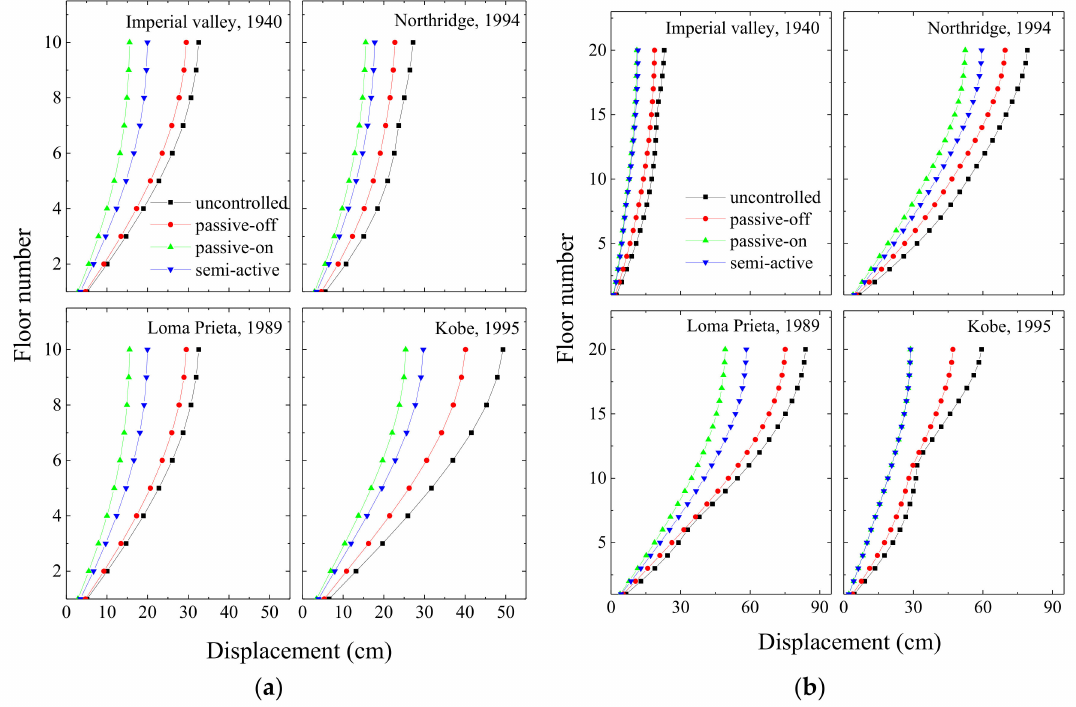
Figure 11. Peak floor displacement under different control states in: ( a ) a coupled stiff building and ( b ) a coupled flexible building when MR dampers are used as coupling devices in Configuration